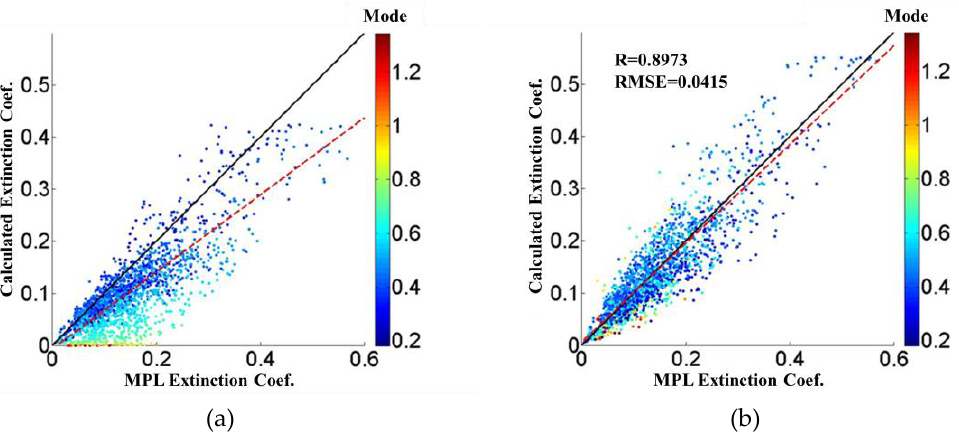
Figure 8. Comparison of the MPLNET extinction coefficient and the calculated extinction coefficient at approximately 0.2 km along with the Mode (denoted by the colored scale) ( a ) before and ( b ) after the height of the surface layer (well-mixed) adjustment. The red dashed line is the regression line, and the black solid line is the 1:1 line.